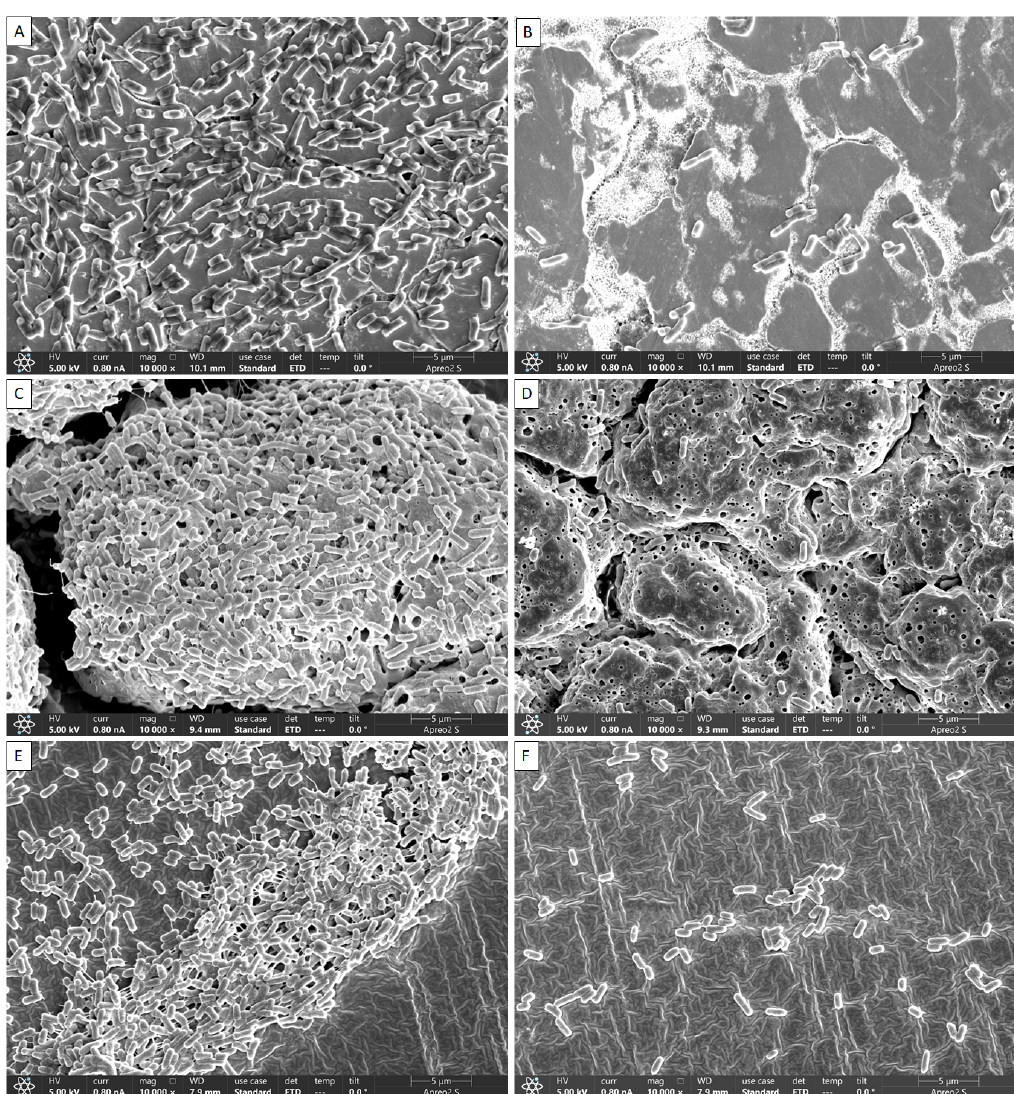
Figure 4. Representative scanning electron micrographs of Listeria monocytogenes mixed-culture biofilms formation DBD plasma treatment on the SS surfaces: ( A ) control; ( B ) 60 min DBD plasma treatment, HG surfaces: ( C ) control; ( D ) 60 min DBD plasma treatment and SR surfaces: ( E ) control; ( F ) 60 min DBD plasma